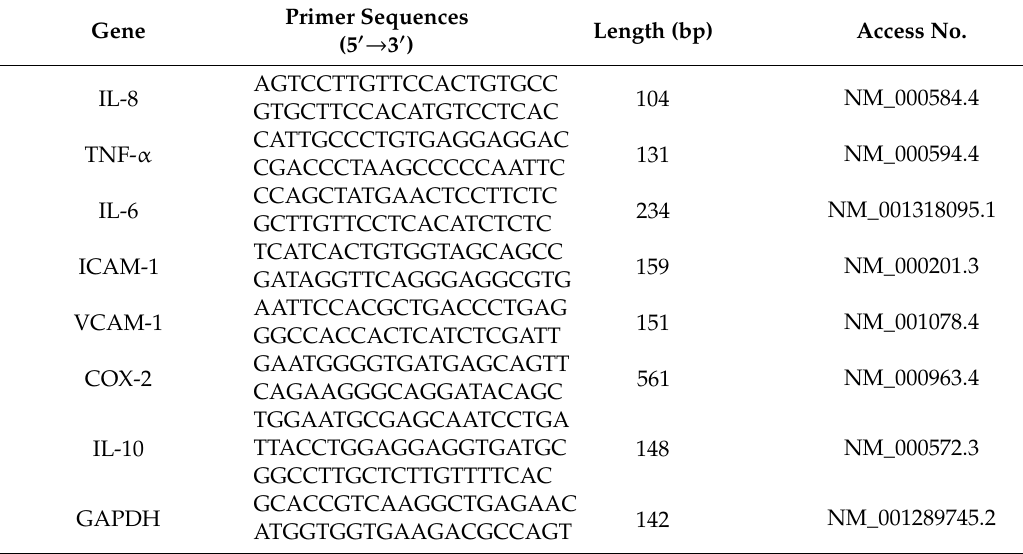
Table 1. Primers used in this study.